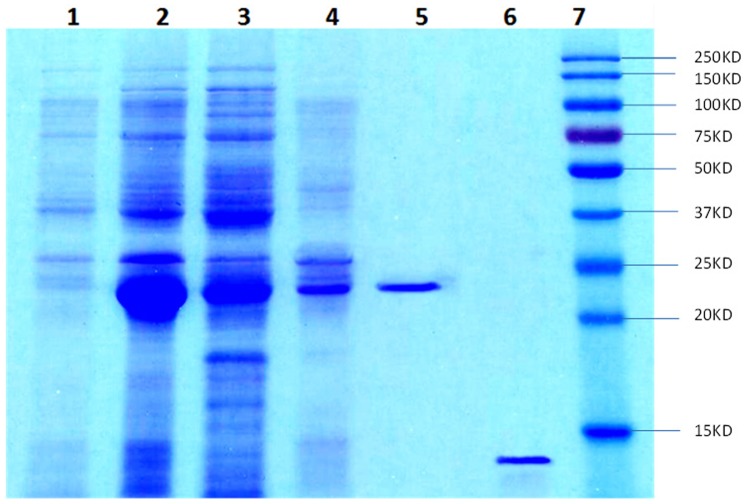
SDS-PAGE analysis of expressed recombine McinOBP1.Lane-1: Non-induced pET32a (+)/McinOBP1 transformed BL21 (DE3) cells; 2: IPTG induced E. coli pET32a (+)/McinOBP1 transformed BL21(DE3) cells; 3. Supernatant after ultrasonic treated pET32a (+)/McinOBP1 cells; 4: Inclusion body of pET32a (+)/McinOBP1 cells; 5: Ni–NTA columns purified proteins; 6. Purified protein cleaved His-tag by rProtease; 7: Molecular weight marker.